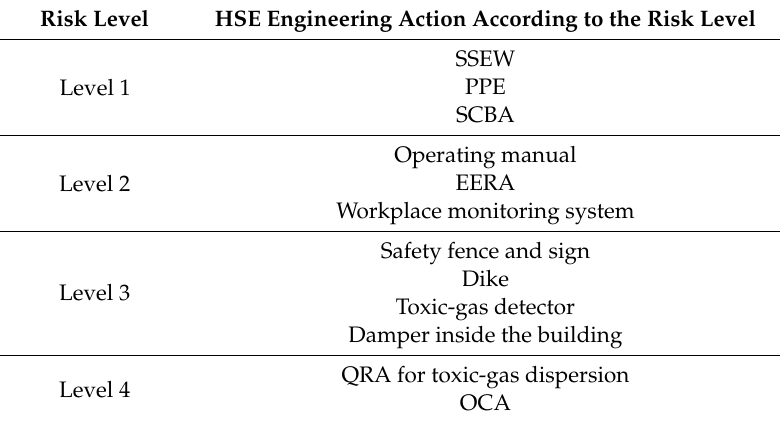
Table 12. HSE engineering actions according to the OSHA modified control of